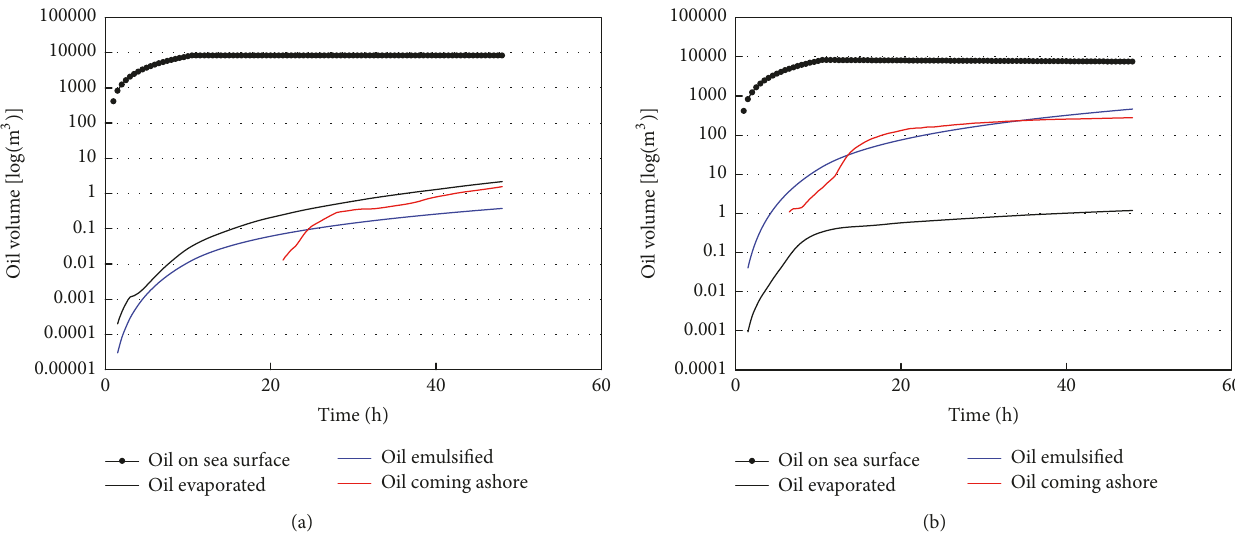
Figure 28: Fate processes of the continuous oil spill that occurred in the west of the channel in the case without wind (a) and in the east of the channel under the action of northwest wind